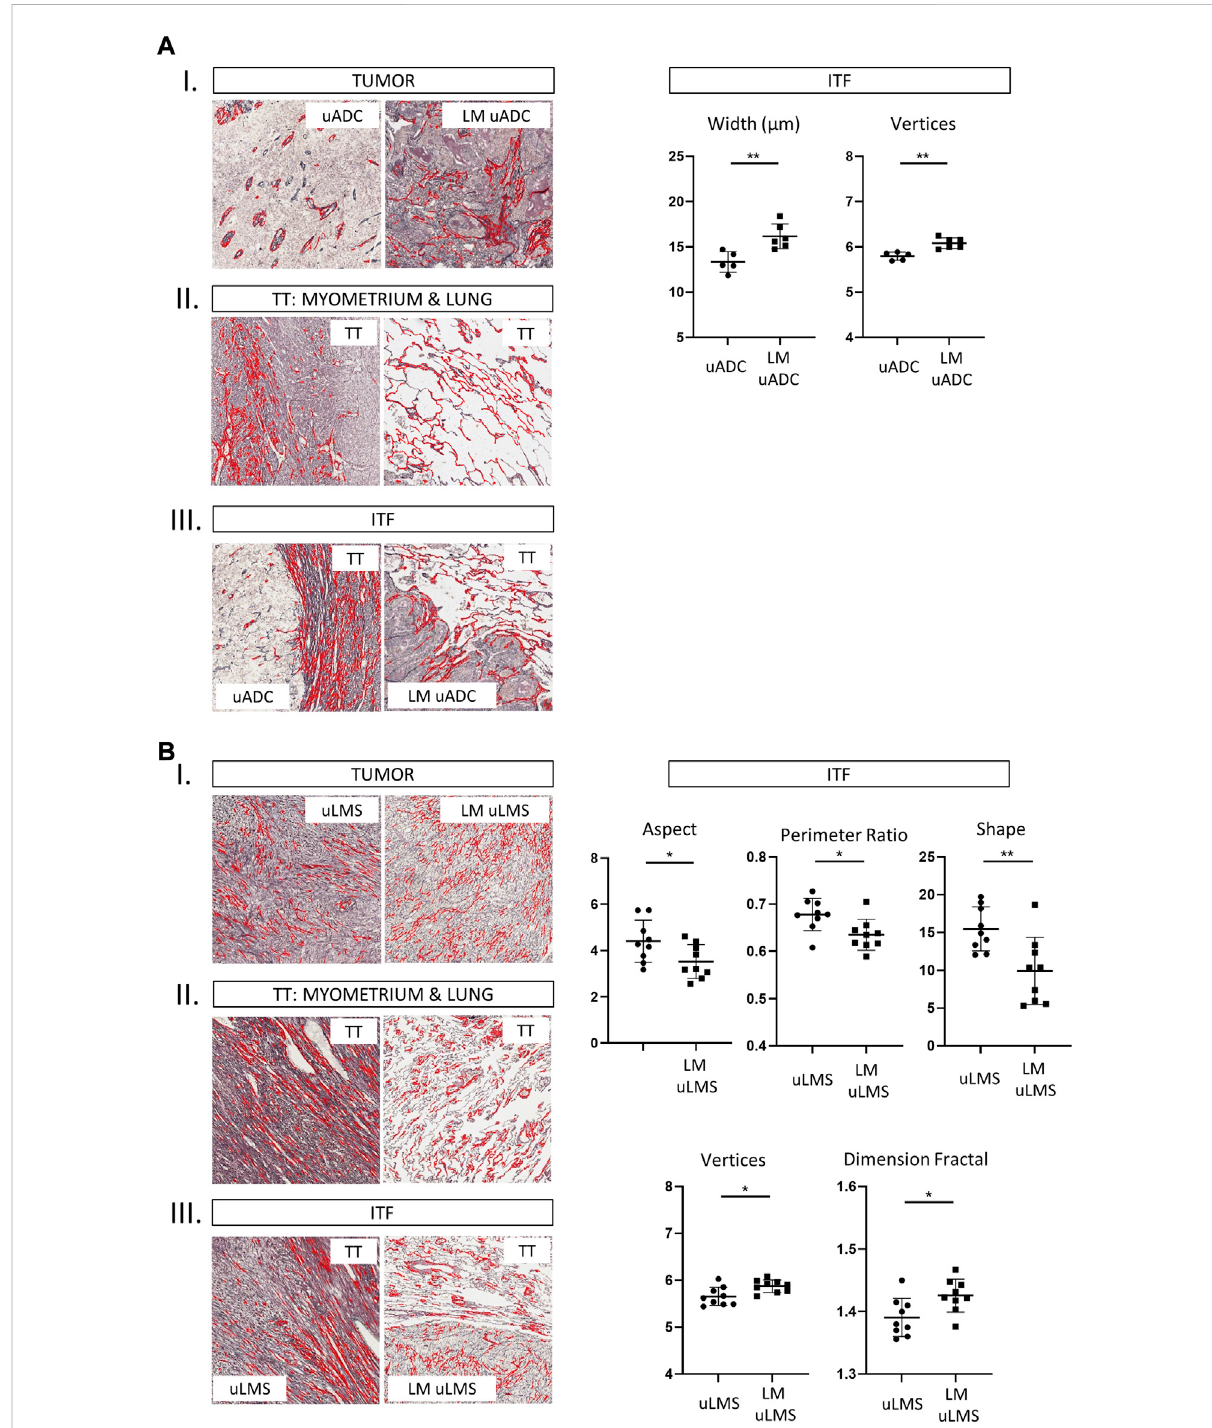
FIGURE 2 Histomorphometric characteristics of reticulin fi bers from analysis of paired tumors at the tumor area, ITF and target tissue in 1 × 1 mm ROIs. Representative images of reticulin fi ber segmentation and statistically signi fi cant results of morphometric parameters. Reticulin fi bers segmented using Gomori ’ s stain (in red) are shown in the histological images. Comparison between primary uterine adenocarcinomas (uADC) and lung metastasis (A) , and primary uterine leiomyosarcoma (uLMS) and lung metastasis (B) . Statistically signi fi cant differences in quantity, size and shape parameters of reticular fi bers are shown ( p values, * < 0.05, ** < 0.01, *** < 0.001). a T, tumor, b. TT, target tissue and c. ITF, invasive tumor front. LM: lung